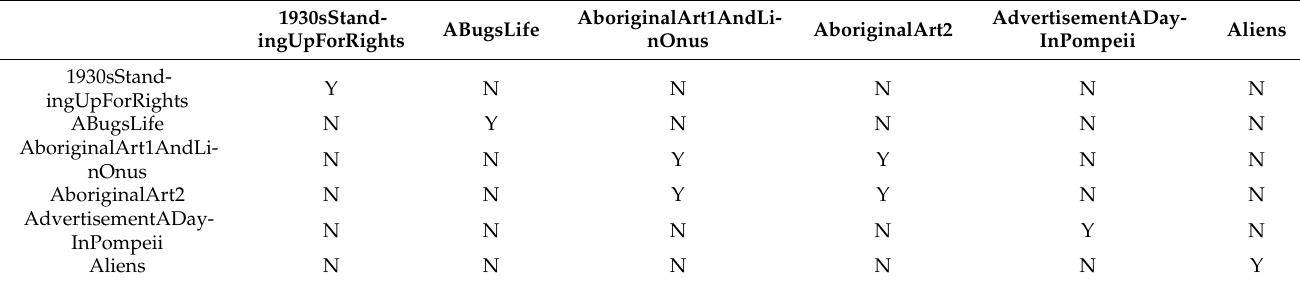
Table 4. Subset of ascertained exhibit area relationships for use in the